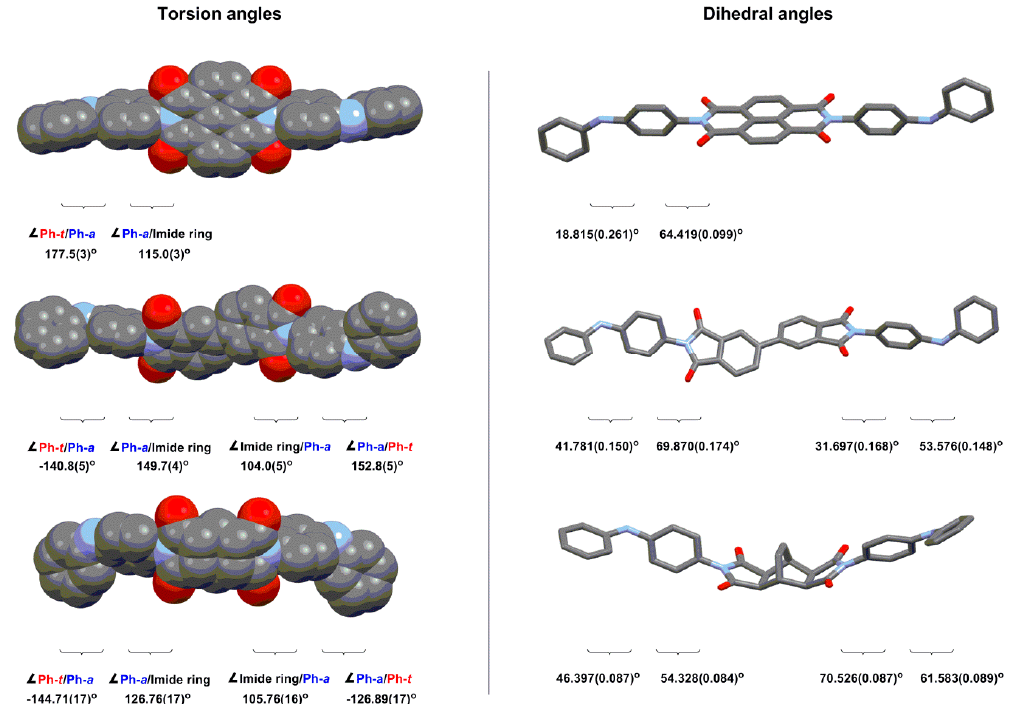
Figure 2. Space filling diagrams (left) with listed torsion angles and dihedral angles (right) were presented. Top left and right diagrams are for 1 , middle left and right diagrams are for 3 ; bottom left and right are for 5 .